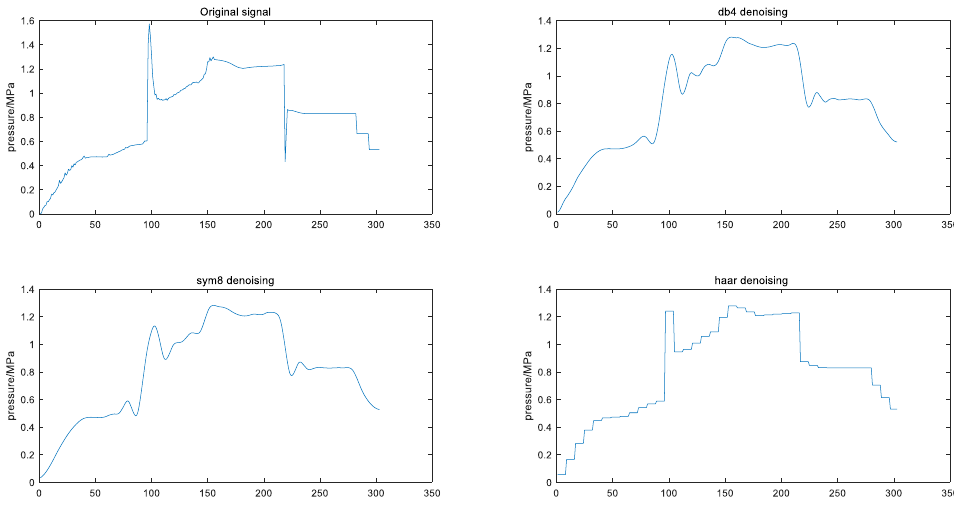
Figure 8. Comparison of the denoising effect of several commonly used wavelet bases.